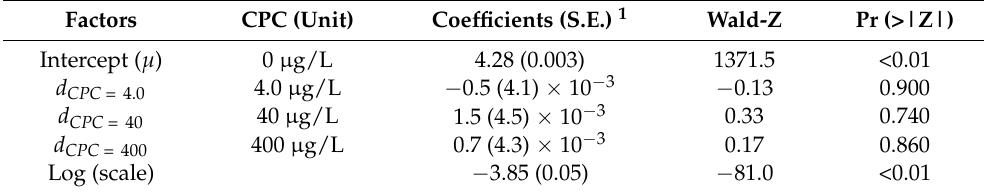
Table 2. Estimated coefficients for an accelerated failure time model describing the effects of cetylpyri- dinium chloride (CPC) on the time to hatching of zebrafish ( Danio rerio ) embryos.